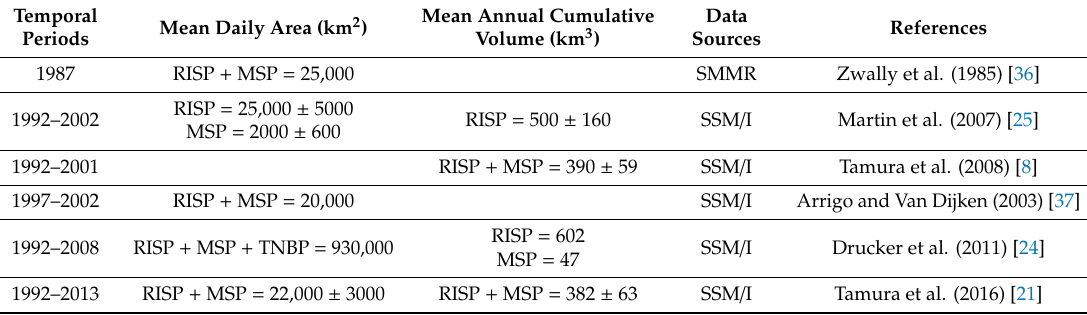
Table 1. Statistics of polynya ice production in the Ross Sea presented in previous